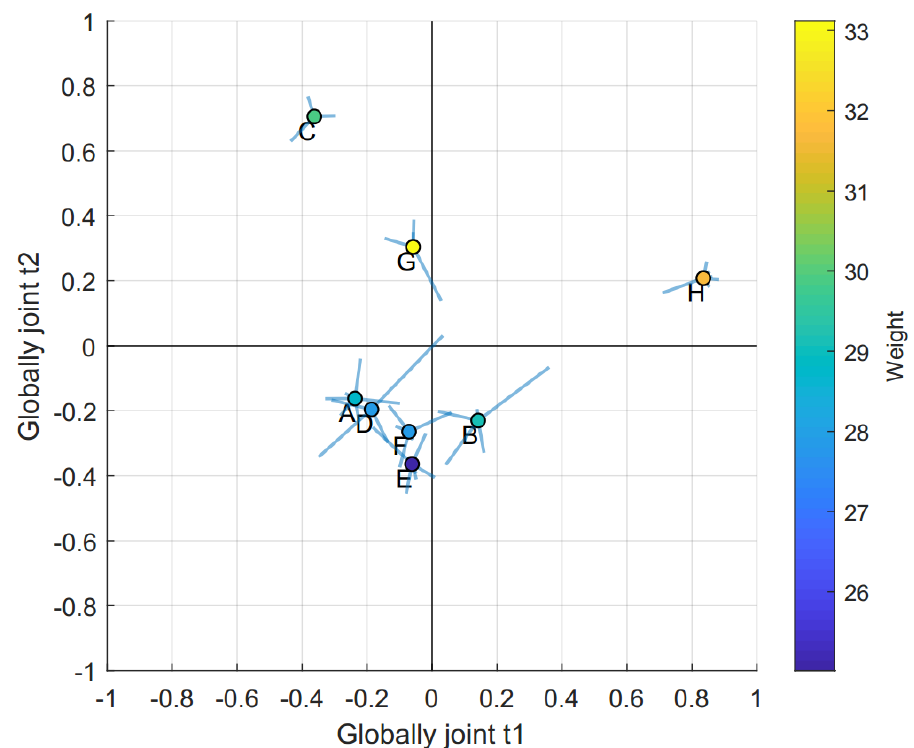
Figure 2. Joint and unique multiblock analysis (JUMBA) multiblock scatter plot t1 vs. t2. The multiblock scatter plot summarized the globally joint scores. The centre scatter circle represented the average score for each mouse and the whiskers represented how much each tissue type differed from this average. The colors of the scatter circles represented the weight of the animals.